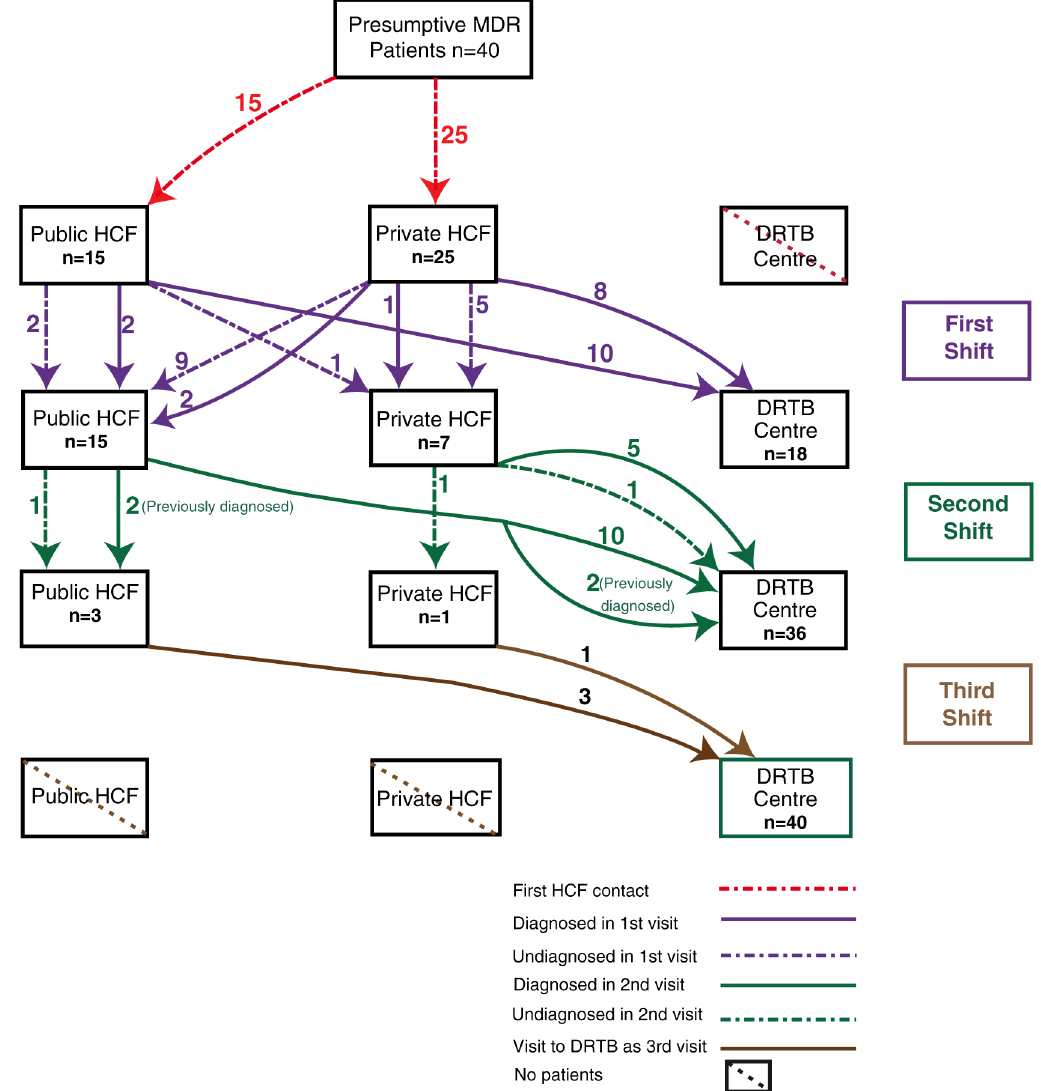
Figure 1. Patient diagnostic and treatment